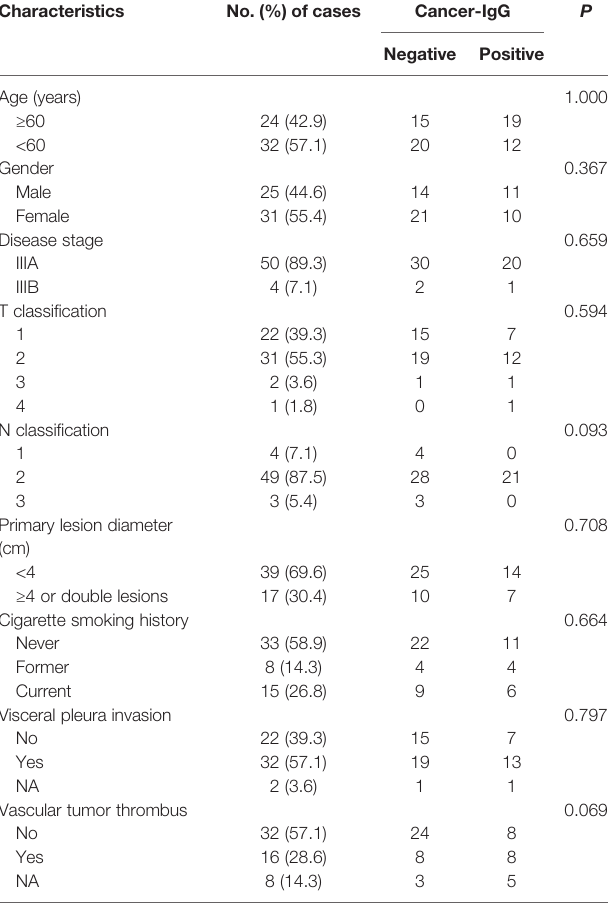
TABLE 1 | Association between cancer-IgG expression and clinicopathological features of patients with lung adenocarcinoma.